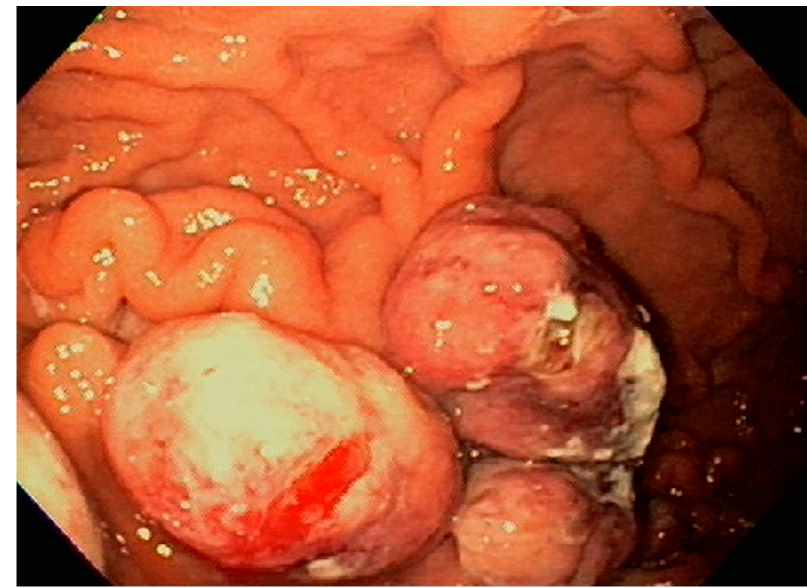
Figure 6. Large friable gastric masses seen on endoscopy. A 61-year-old male with recurrent marginal zone lymphoma on chemotherapy presented for endoscopic evaluation for iron deficiency anemia. Colonoscopy revealed tubular adenomas, upper endoscopy revealed a clean based gastric ulcer and gastric erosions (Figure 7). Sloughing was also noted in mid esophagus with biopsies consistent with esophagitis dissecans superficialis (Figure 8). The gastric ulcer biopsies showed ulceration with granulation tissue along with large, atypical cells concerning for lymphoma (Figures 9 and 10).